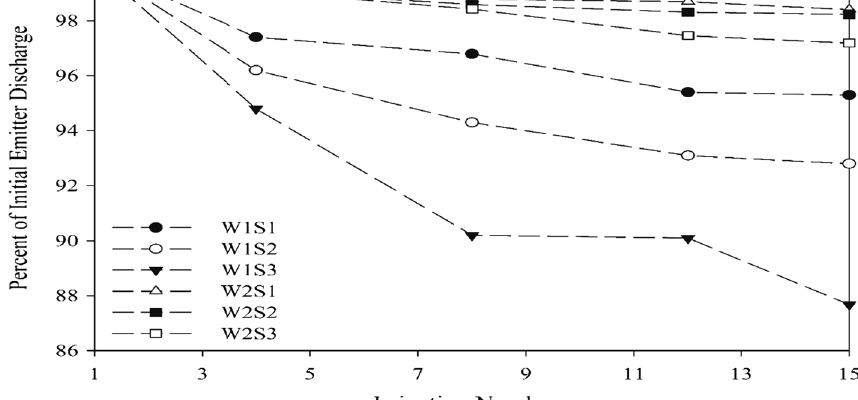
In each column and for each treatment, the values followed by at least one common character are not statistically different at 0.05 probability level Fig. 3 Variations of dripper discharge during the experiment period